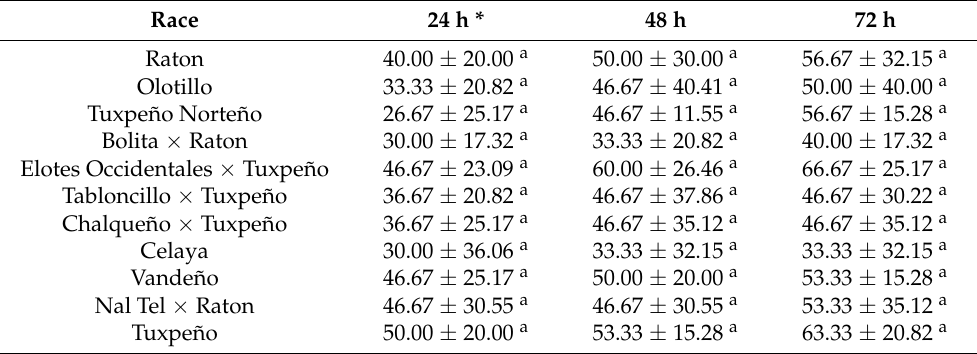
* Means values and ± standard deviation (SD) is presented. Same letters indicate are not significantly different ( p > 0.05; MANOVA and LSD’s test).